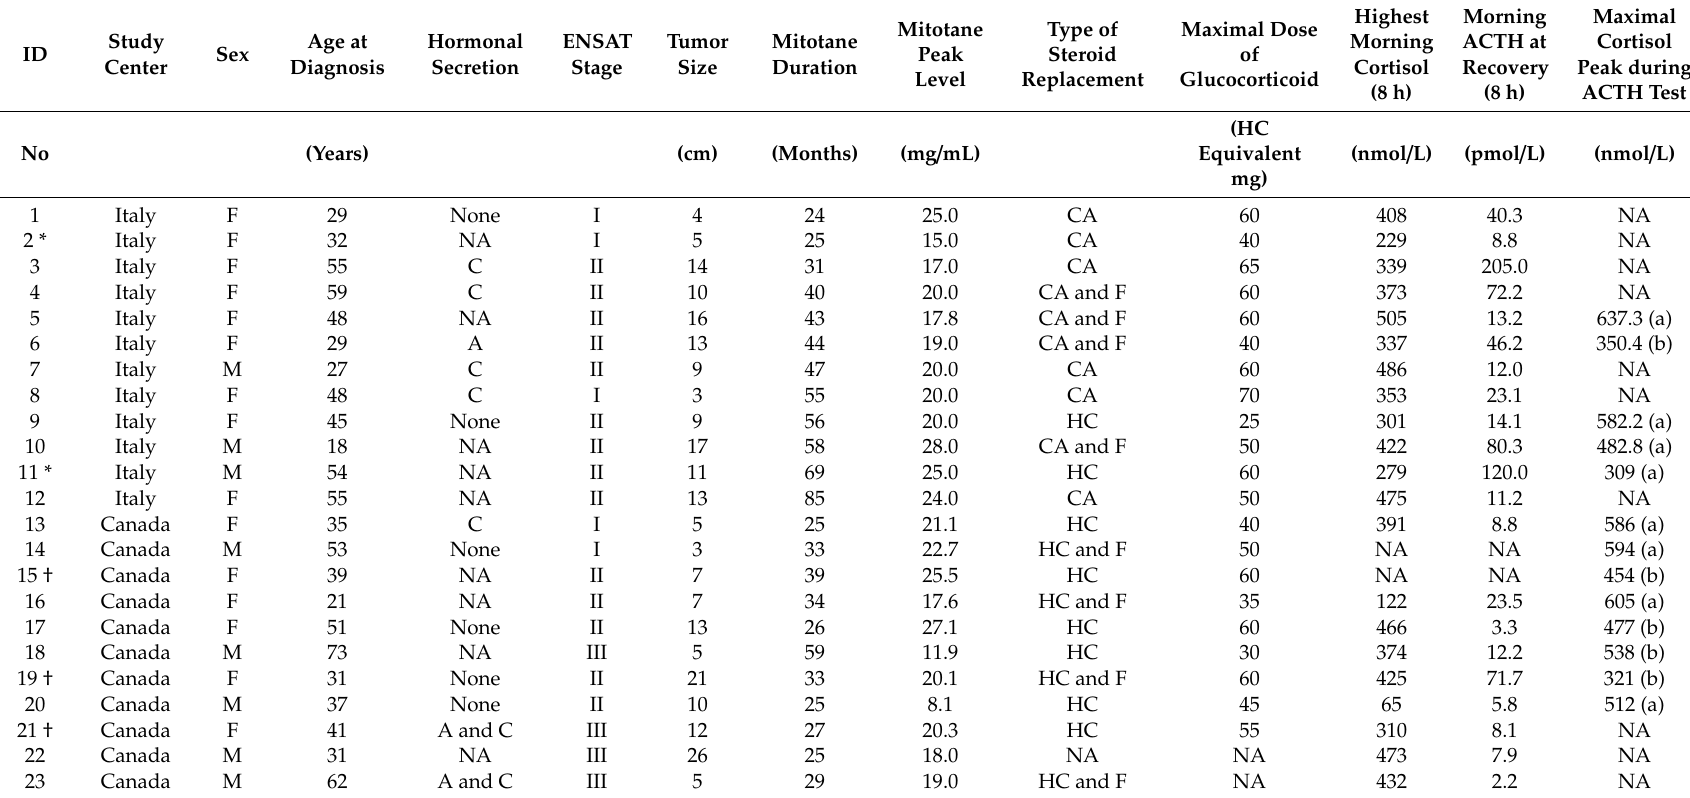
Table 1. Summarized data of each patient with adrenocortical cancer (ACC) treated with mitotane including tumor characteristics, treatment, and HPA axis